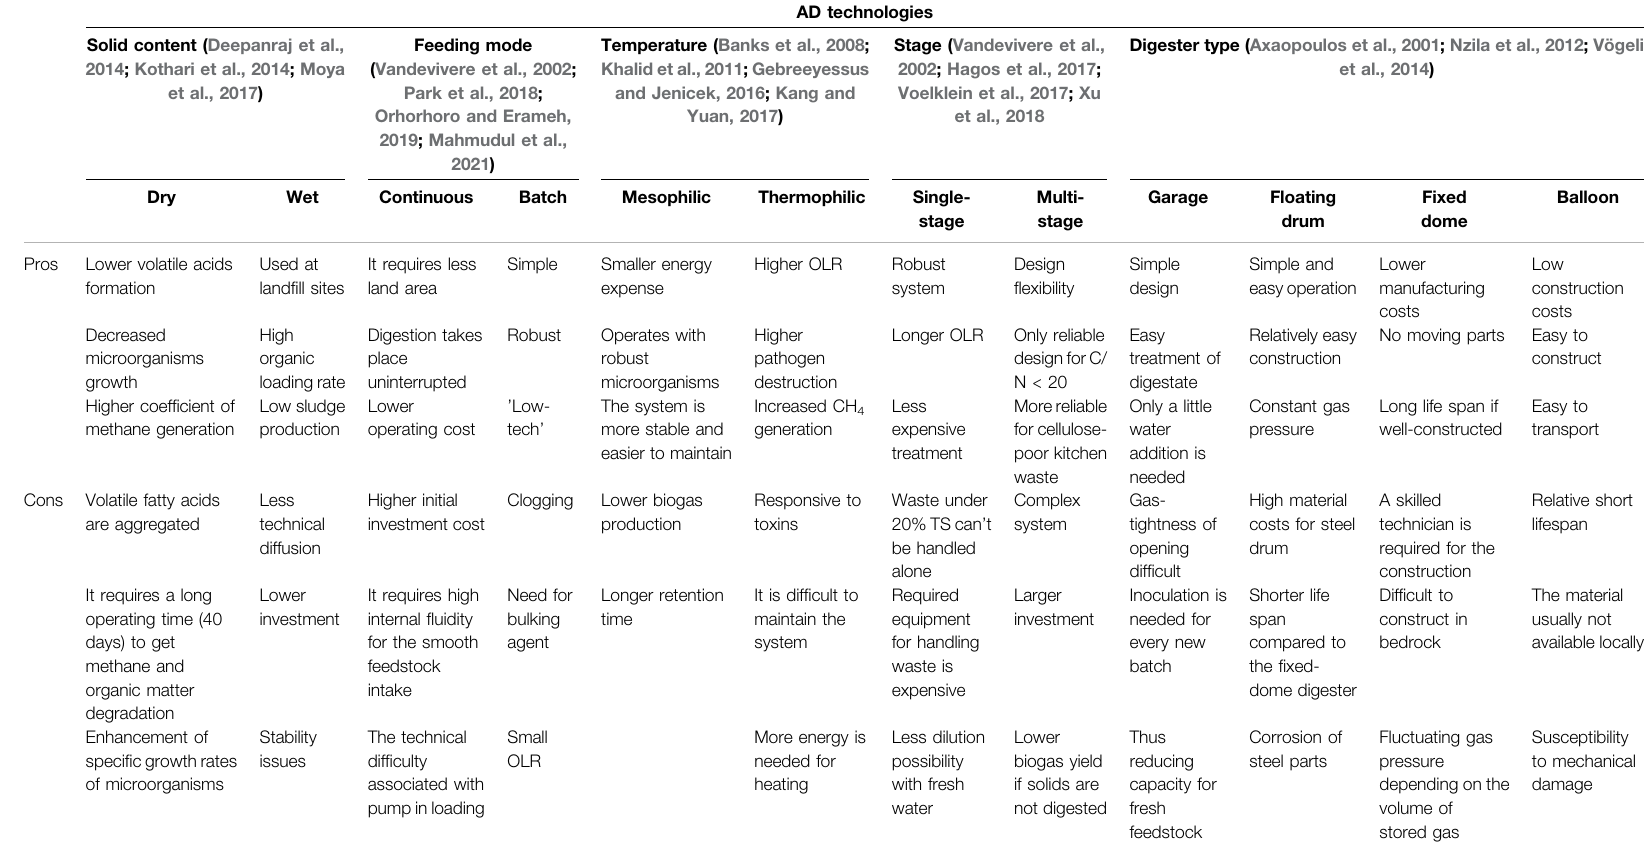
TABLE 1 | Pros and Cons of different AD technologies.